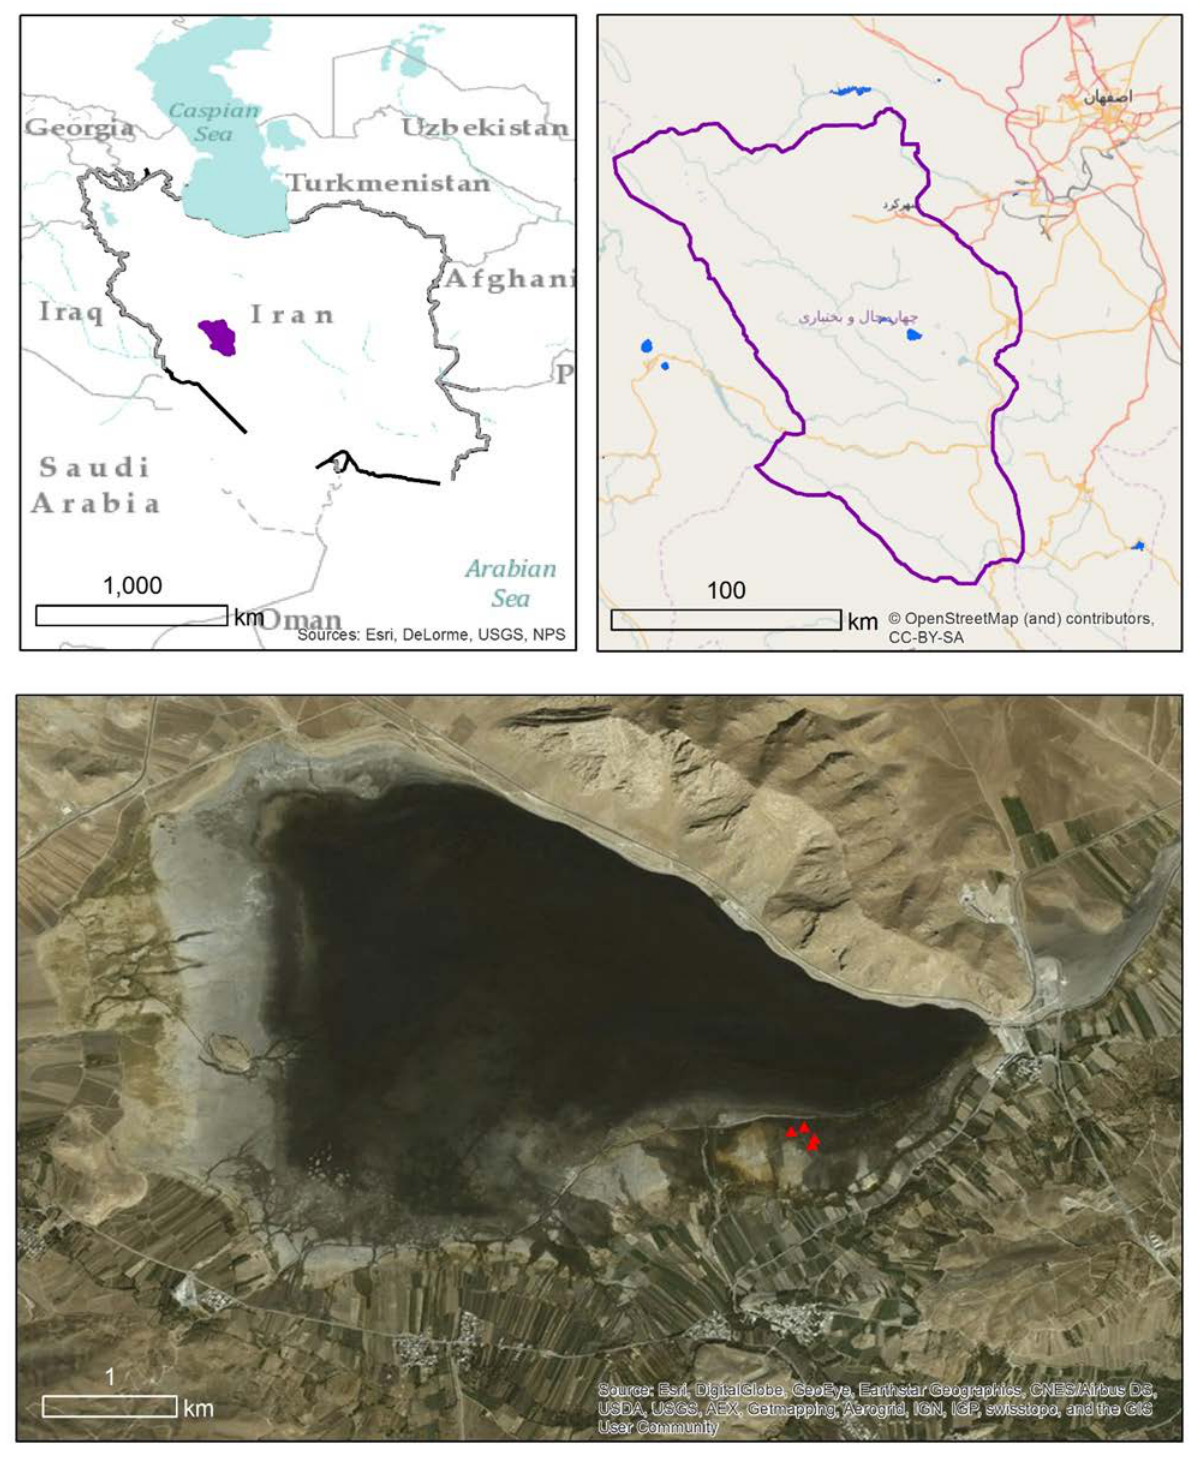
Figure 1. Location of the site where peat was collected. Top left: location of Chahar Mahal and Bakhtiari Province (purple filled shape) within Iran. Top right: location of Chaghakhor Wetland within Chahar Mahal and Bakhtiari Province (purple outline); the area of water (blue) at right-centre of the province represents Chaghakhor Wetland and the population centre at top right of the map is Isfahan. Bottom: remotely sensed imagery of Chaghakhor Wetland and its surroundings, showing the locations of the four sampling pits (red